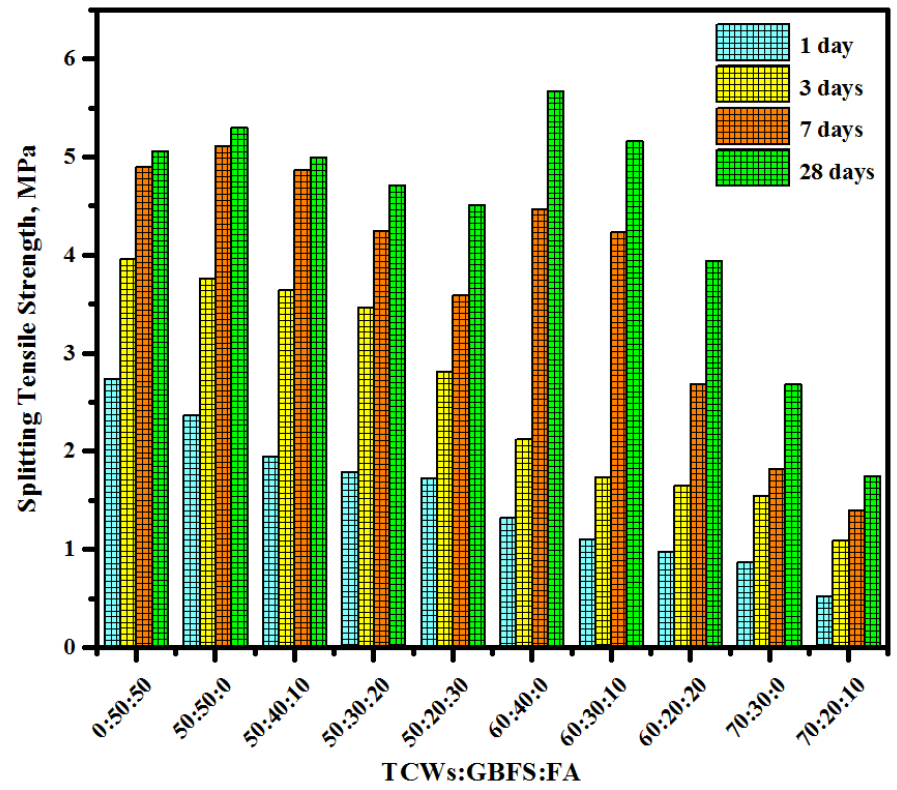
Figure 8. Effect of TCWs content on splitting tensile strength of GPMs at different curing ages.